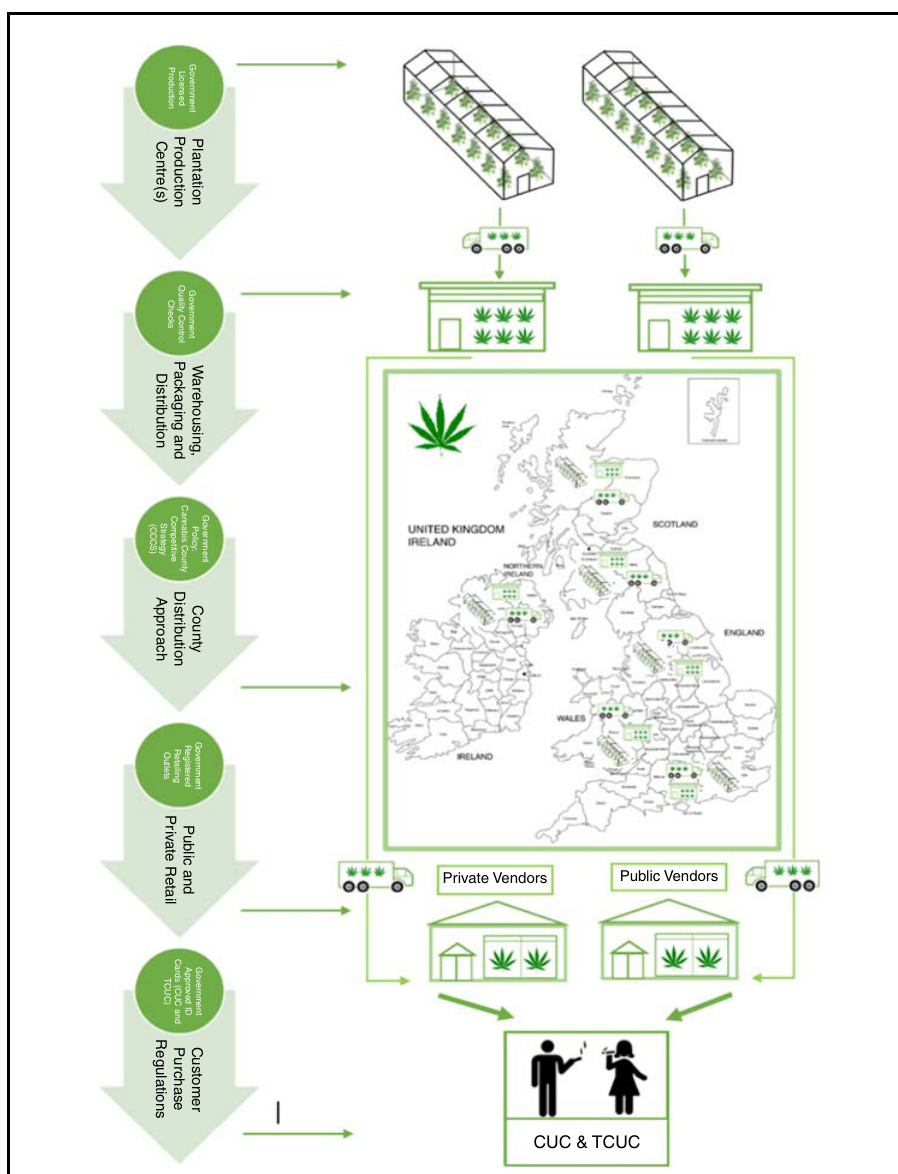
Figure 1 Cannabis production and distribution